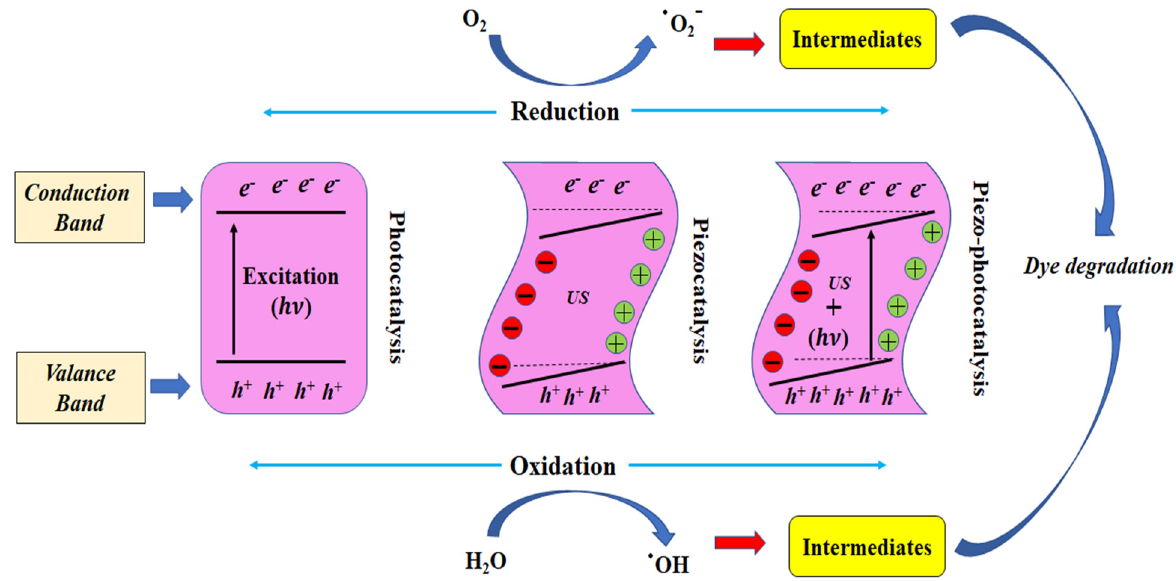
Figure 10. A plausible mechanism of photocatalysis, piezocatalysis, and piezo-photocatalysis pro-